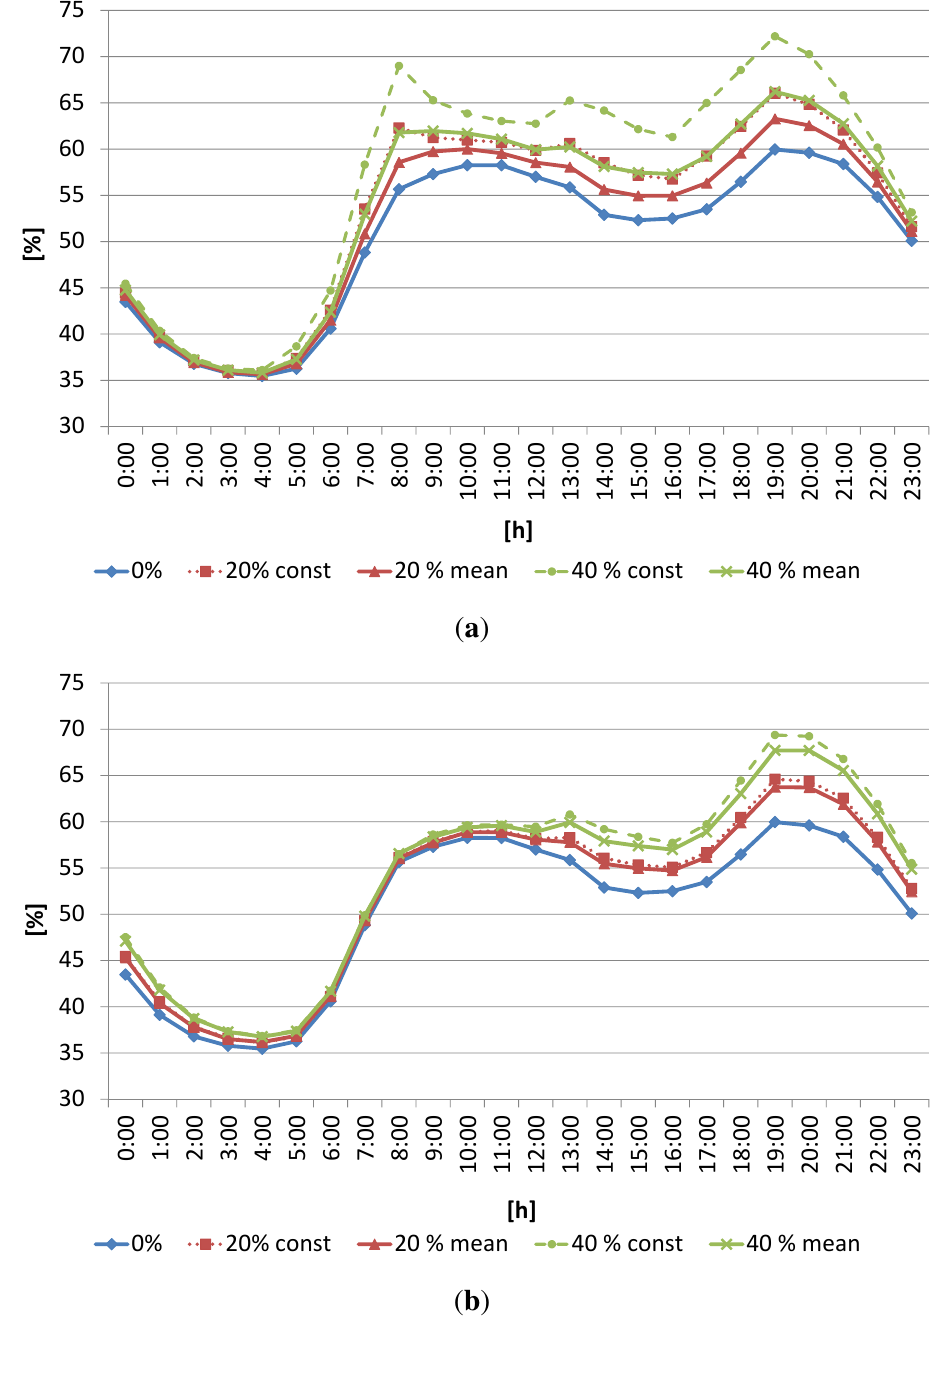
Figure 12. Loading profile of the Line 1 (L1) through a winter weekday. ( a ) Recharge of the battery at the end of each travel; ( b ) Recharge of the battery at the end of all day travels.